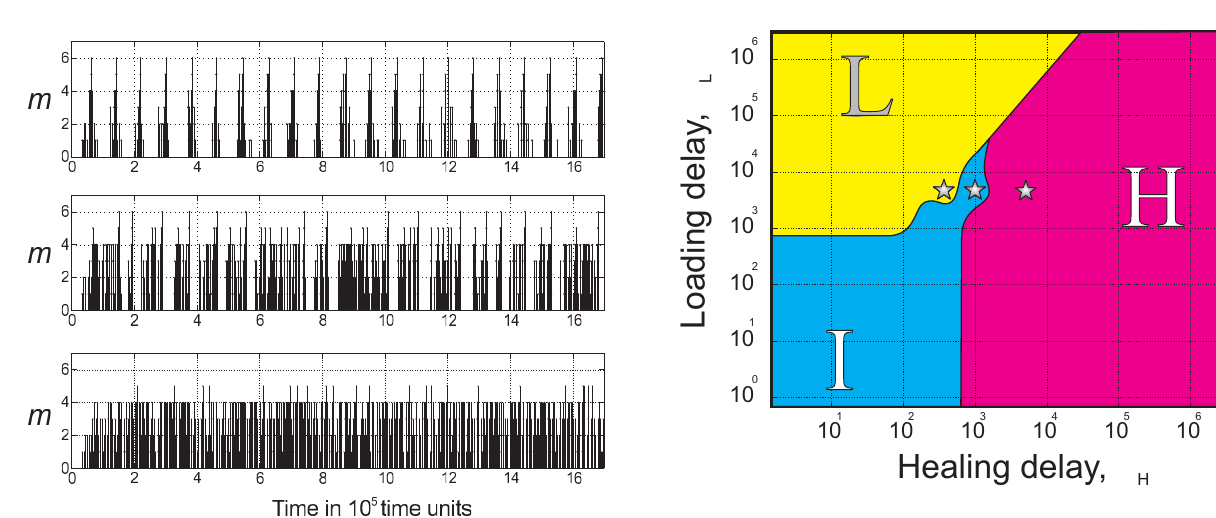
Fig. 11. Regime diagram in the (∆ L , ∆ H ) plane of the loading and healing delays. Stars correspond to the sequences shown in Fig. 10. Reproduced from Zaliapin et al. (2003a), with kind permission of Springer Science and Business